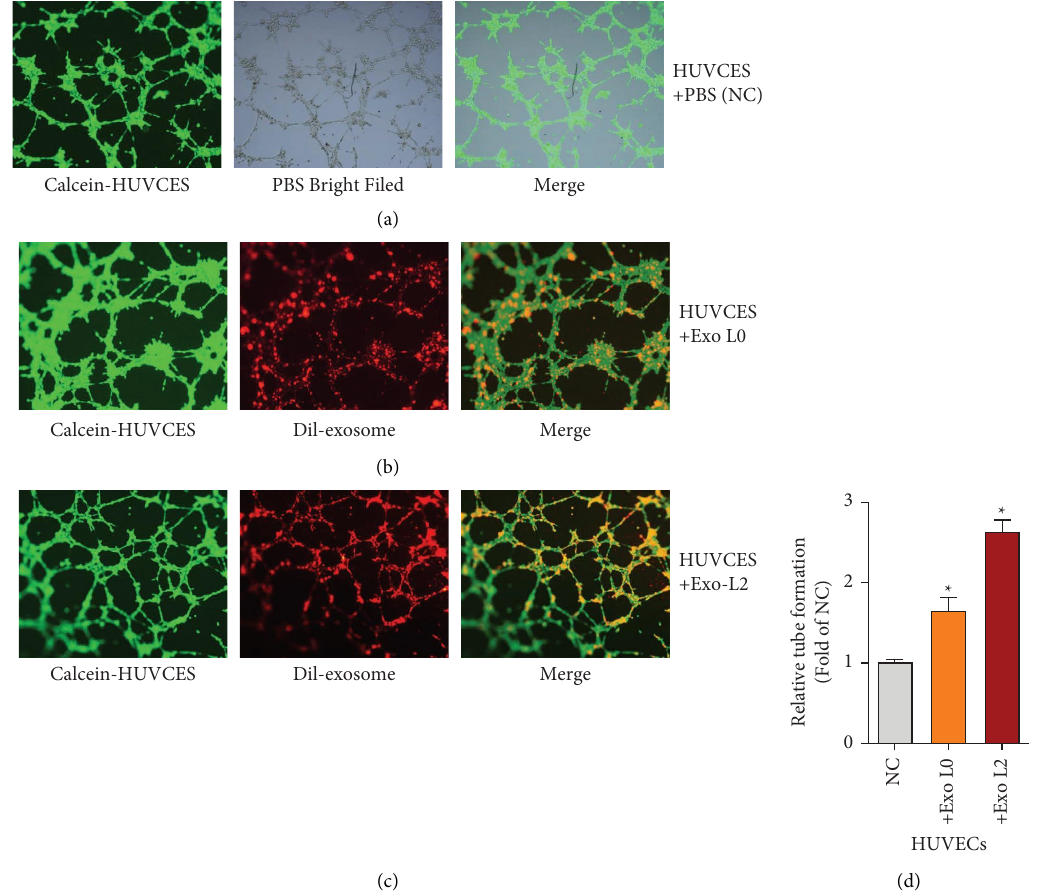
Figure 1: Tumor-derived exosomes promote tumor angiogenesis in recipient PDAC cells Te in vitro angiogenesis abilities of the indicated treated HUVECs (A–D) were measured by tube formation assays. Magnifcation, ×